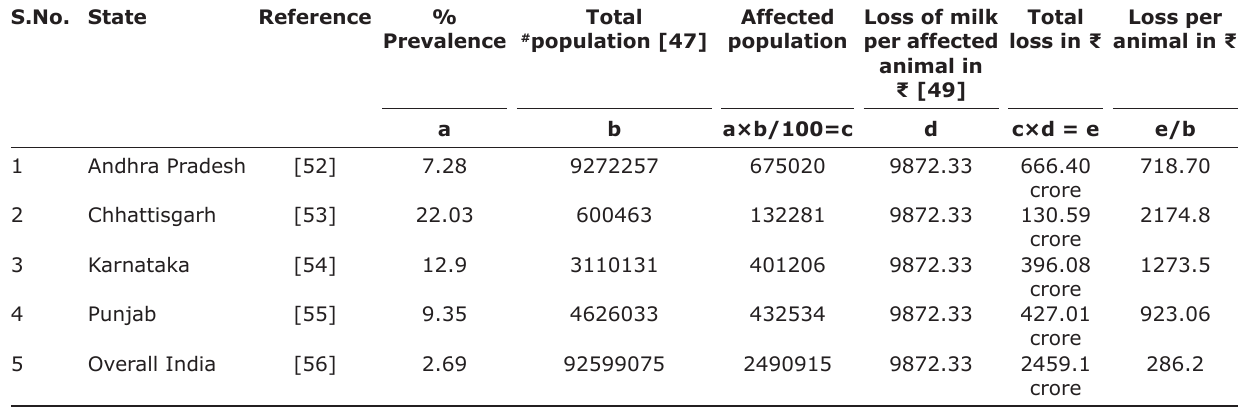
Table-4: Projected economic losses due to trypanosomosis in buffaloes in India. S.No. State